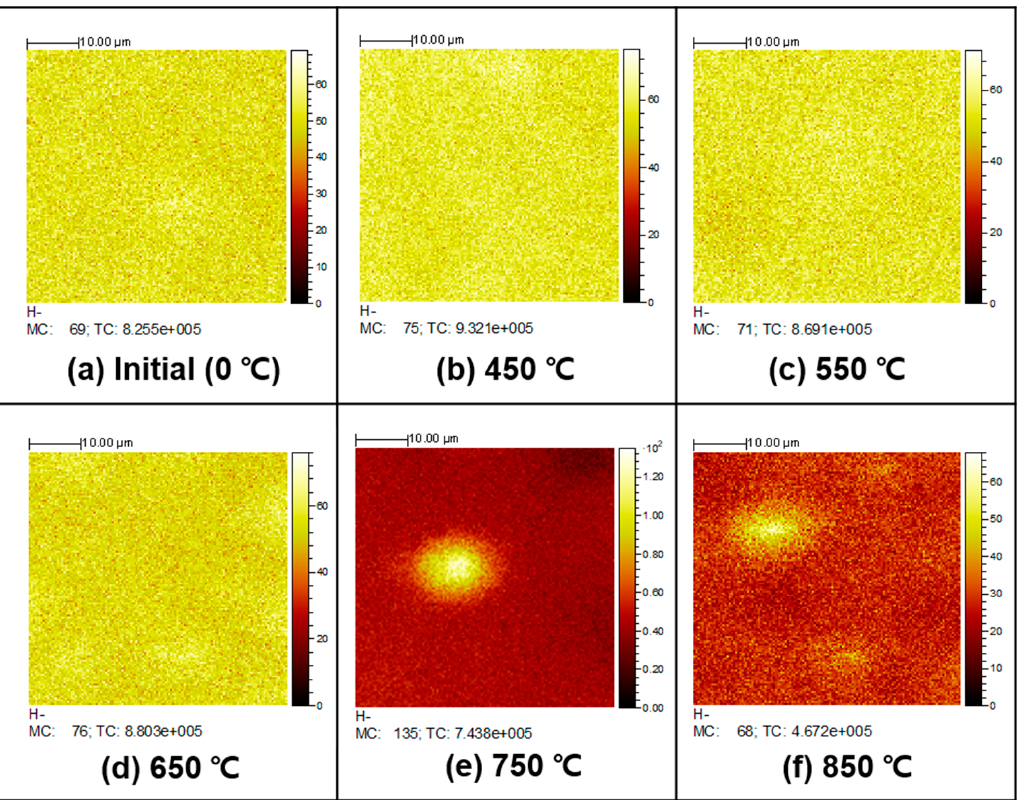
Figure 6. Results of mapping of hydrogen distribution at ( a ) 0 °C (initial), ( b ) 450 °C, ( C ) 550 °C, ( d ) 650 °C, ( e ) 750 °C, and ( f ) 850 °C.